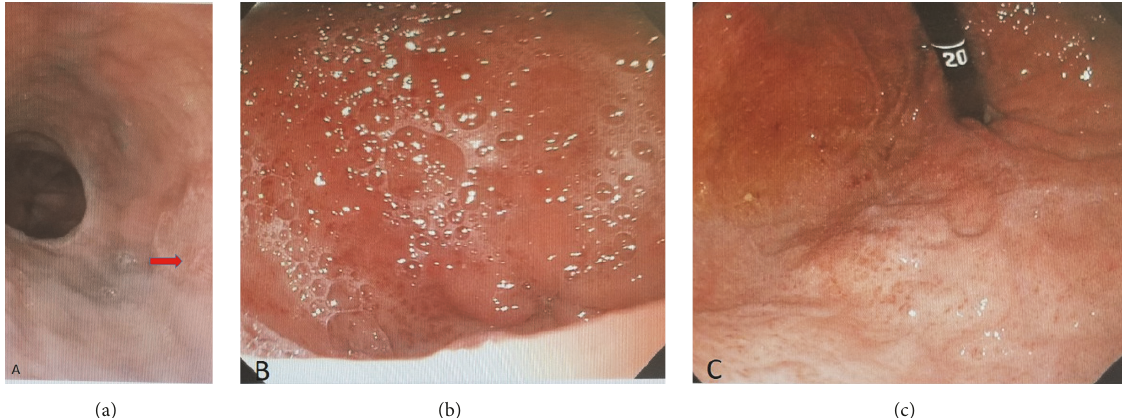
Figure 1: Endoscopy findings of ulcerations in the distal esophagus (arrow) from prior banding of small esophageal varices and diffuse portal hypertensive